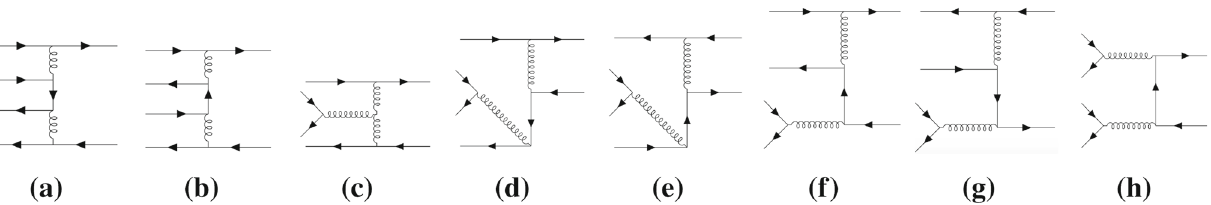
Fig. 3 The transition T ↔ q ¯